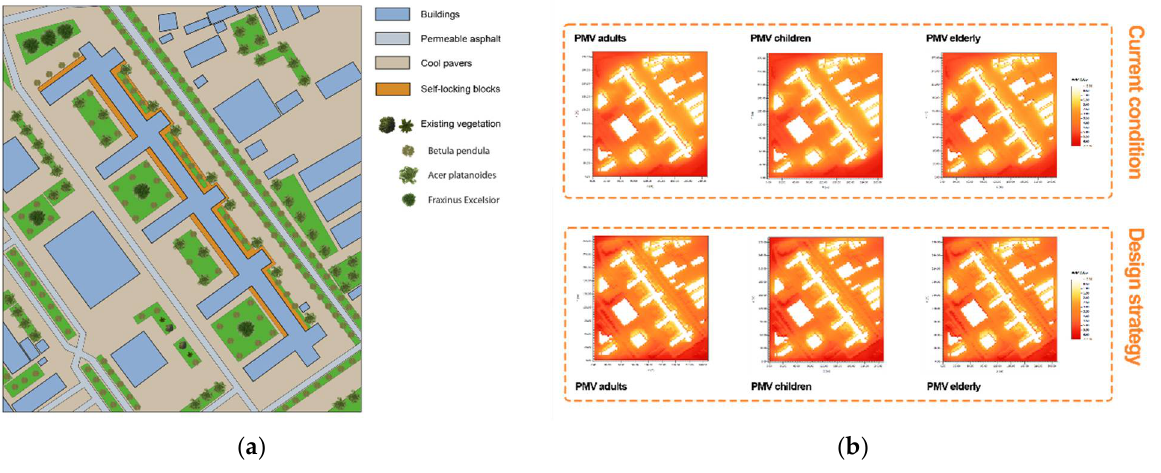
Figure 14. Outdoor redevelopment of the Ponticelli area with climate-proof technical solutions: ( a ) Meta-design of the climate adaptive redevelopment interventions; ( b ) Comparison of the PMV analyses for the three categories of users in the current meta-design scenario.